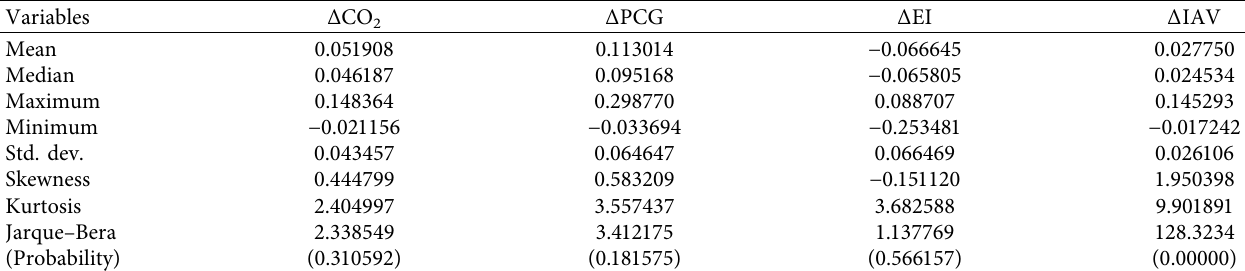
Table 5: Description and statistical analysis of stationary